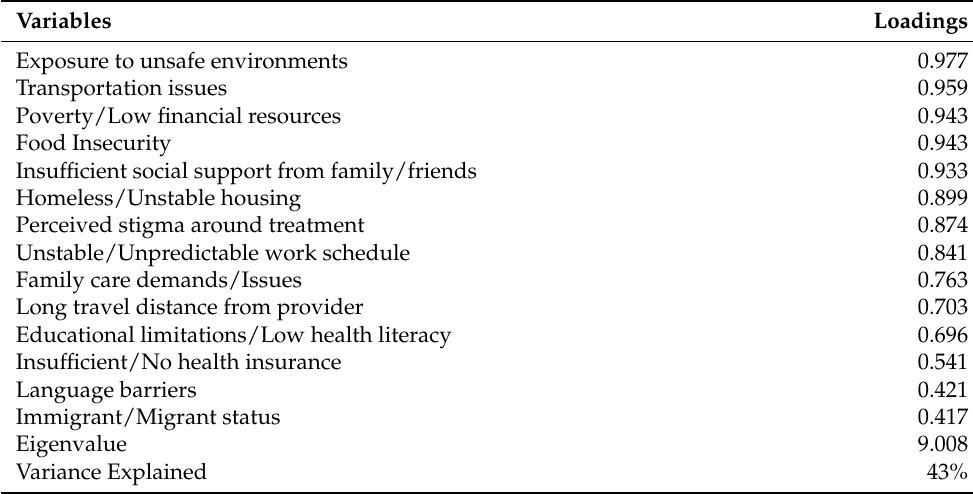
Table A1. Results of principal components analysis for the portion of patients experiencing social determinants of